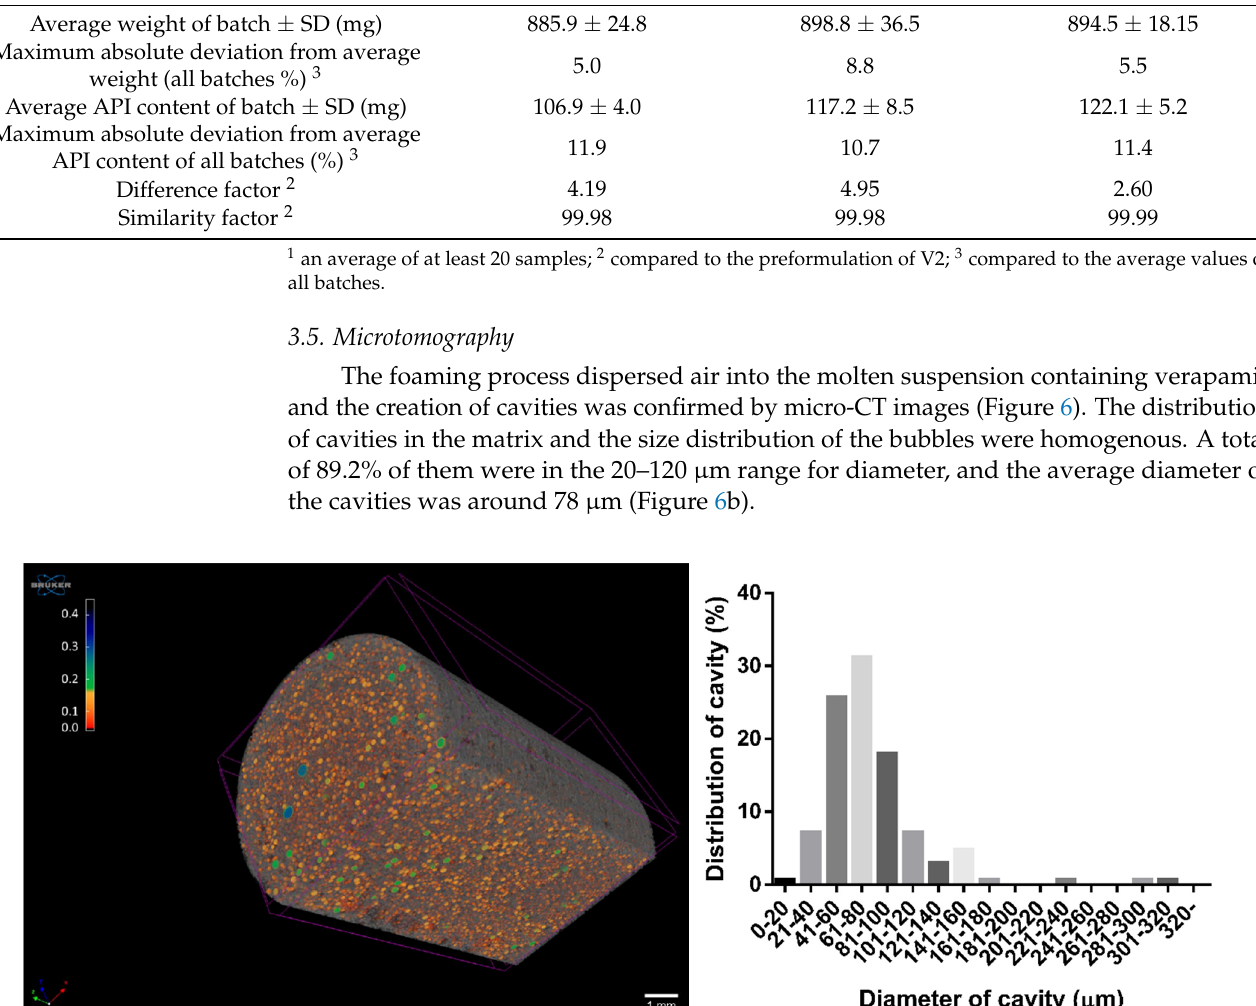
small compared to the whole matrix (Figure